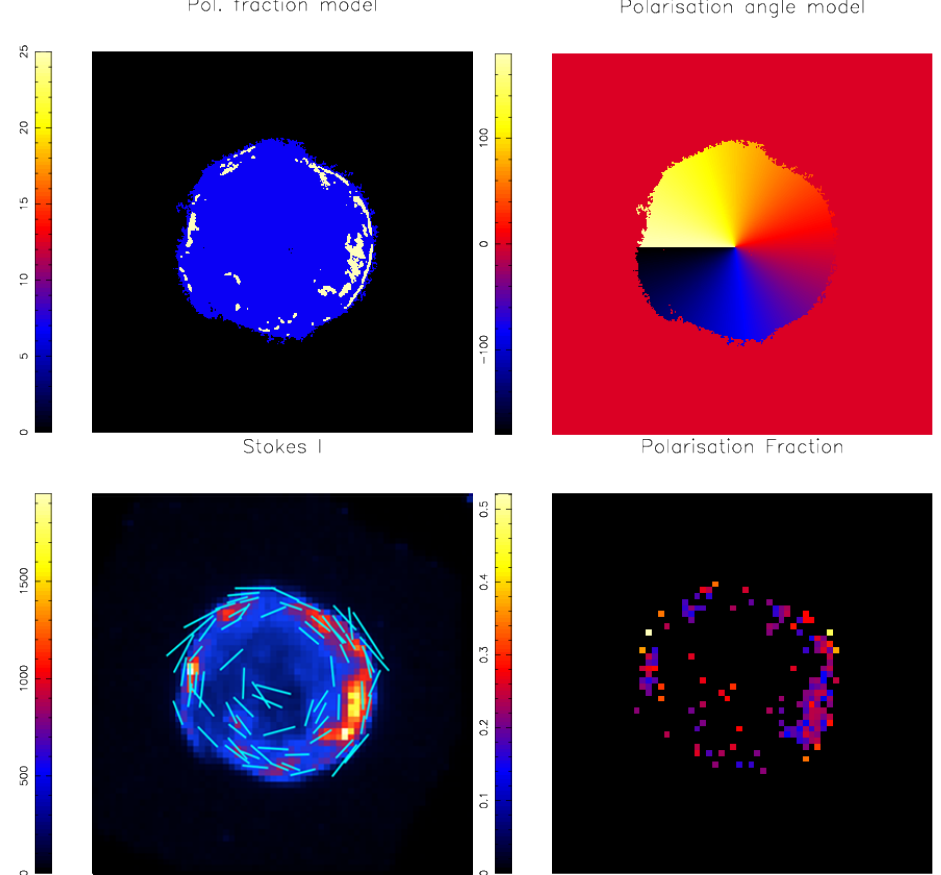
Figure 7. Simulations using a toy input model for Tycho’s SNR, based on the Chandra 4–6 keV image and input maps of polarisation fraction and angle, and assuming an observation time of 2 Ms. The output images are binned to 16 (cid:48)(cid:48) pixels. ( Top left ) Input model for polarisation fraction (in %). ( Top right ) model for the polarisation angle (in degrees). ( Bottom left ) Simulated 4–6 keV count image (Stokes I). ( Bottom right ) reconstructured polarisation